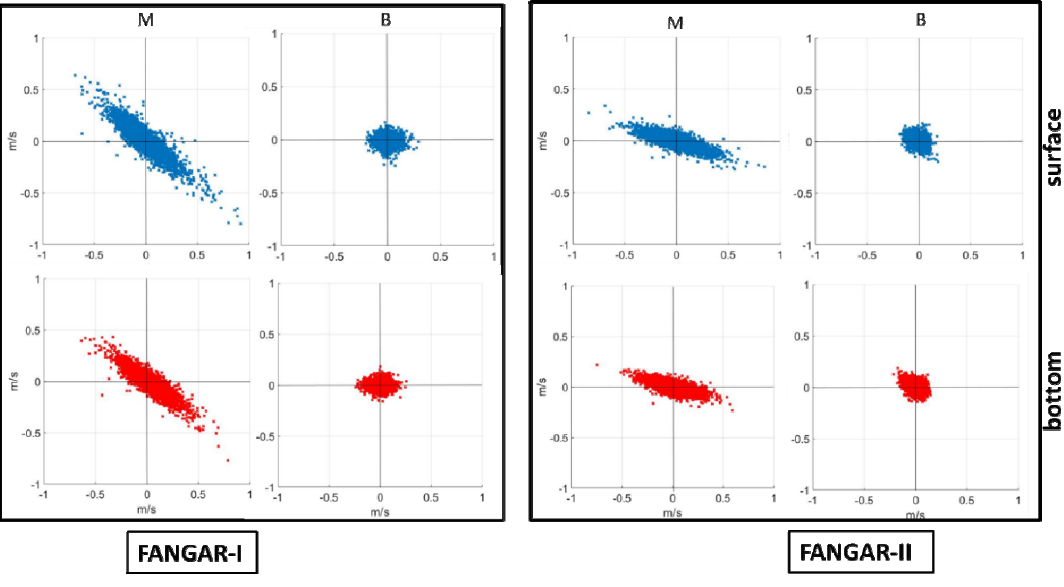
Figure 5. Dispersion diagram for FANGAR-I ( left ) and FANGAR-II ( right ), in blue the surface water circulation and in red the bottom water circulation. The first column of panel corresponds to the measurements in the mouth (M) and the second column to those within the bay (B).